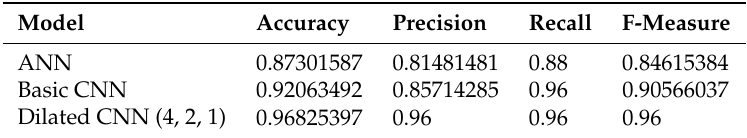
Table 2. Accuracy, Precision, Recall and F-measure compared across Simple ANN, Basic CNN and Dilated CNN.